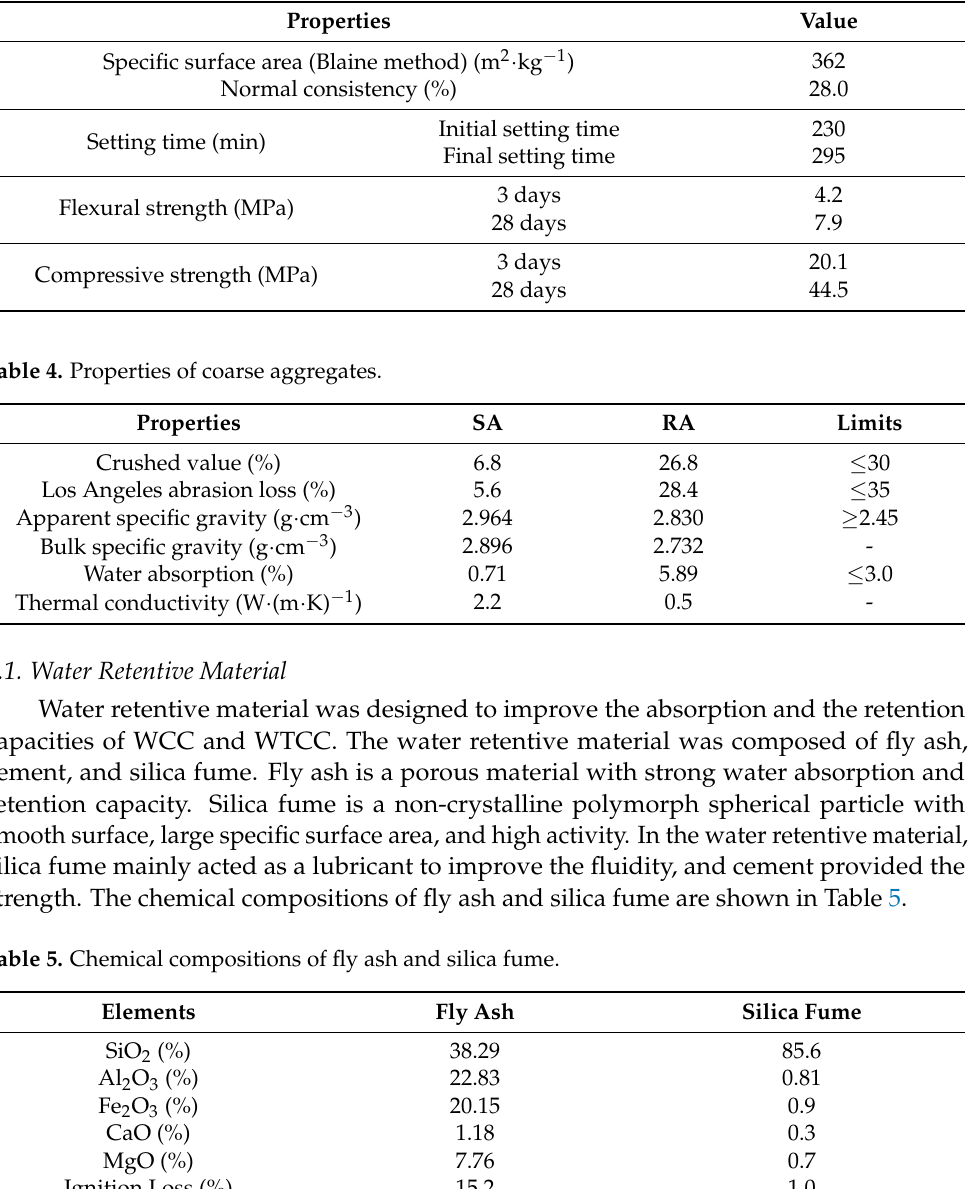
Table 3. Properties of cement.